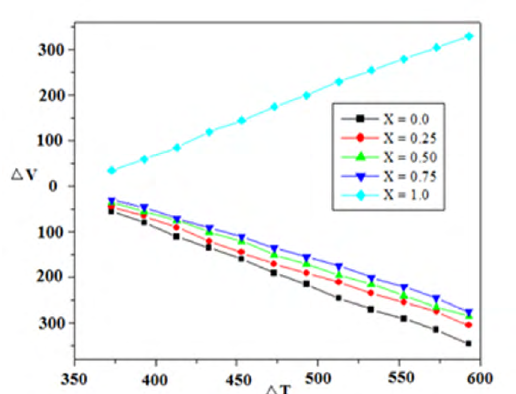
Figure 7. Plots of Δv Vs ΔT for the system Zn